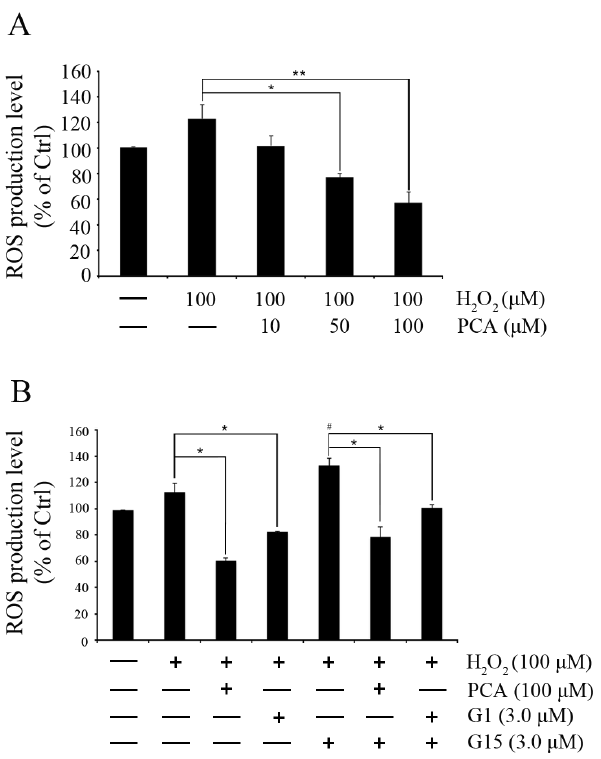
Figure 2. Protocatechuic aldehyde decreases ROS production. ( A ) HUVECs were pretreated for 24 hrs with various concentrations (10, 50, 100 m M) of PCA. ( B ) HUVECs were pretreated for 24 hrs with PCA (100 m M) and G1 (3.0 m M) and for 6 hrs with G15 (3.0 m M). Then, ( A, B ) HUVECs were treated with H 2 O 2 (100 m M/ml) for 1 hr followed by measurement of ROS levels. ( A, B ) Both experiments are representative of 3 independent experiments. Data are presented as mean 6 SEM; * P , 0.05, ** P , 0.005, # indicates P , 0.05 compared to the control